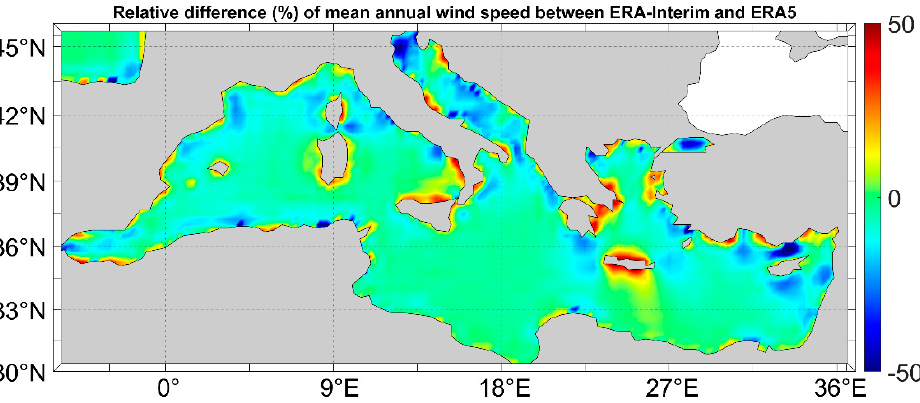
Figure 3. Relative difference of the mean annual wind speed obtained from ERA5 and ERA-Interim datasets.